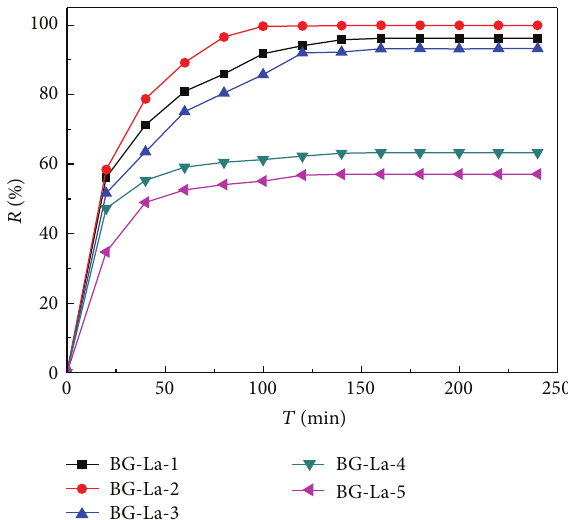
Figure 9: The pseudo-second-order kinetics of MB by BG-La.